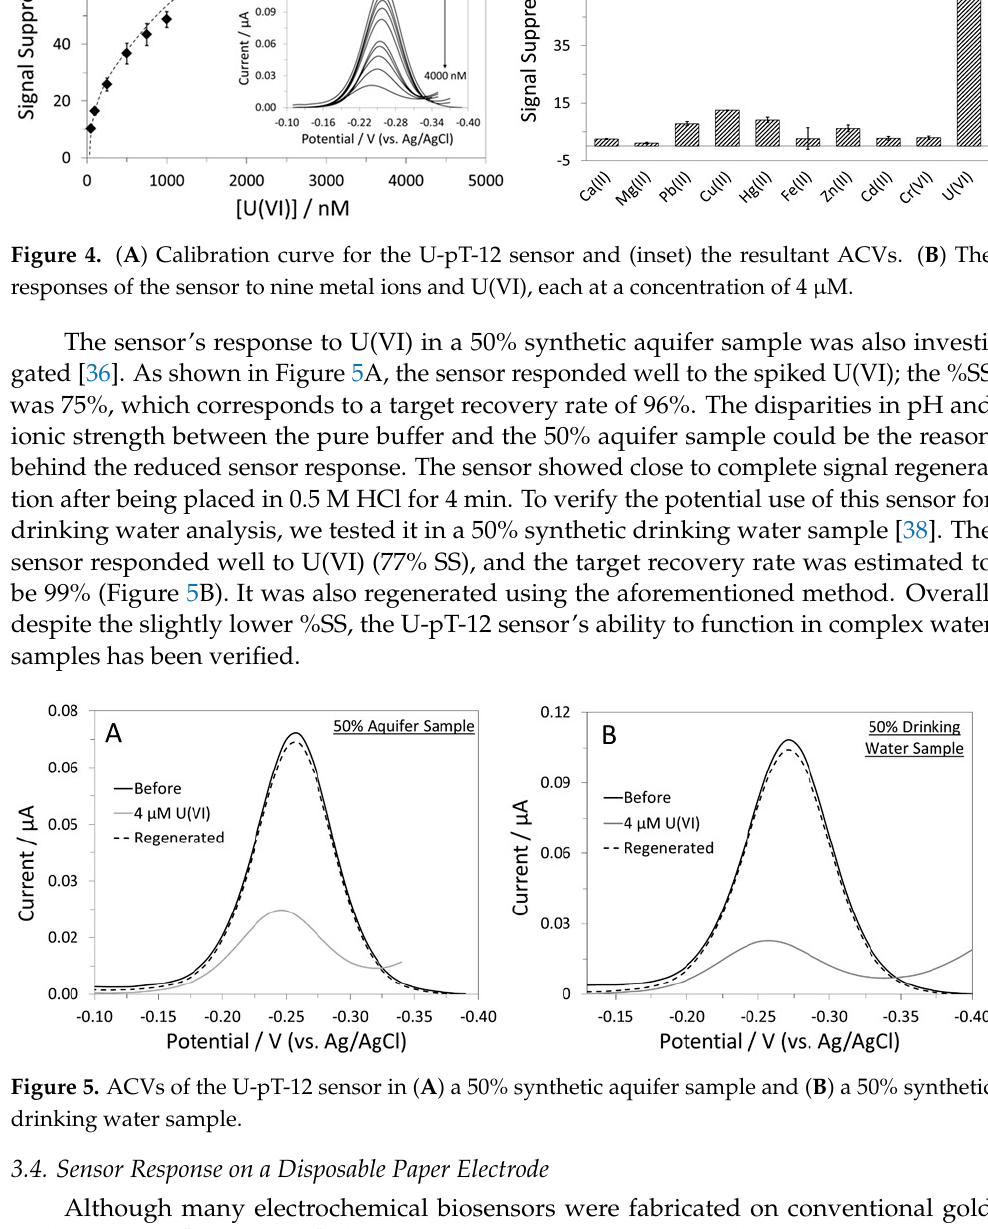
Figure 4. ( A ) Calibration curve for the U-pT-12 sensor and (inset) the resultant ACVs. ( B ) The re- sponses of the sensor to nine metal ions and U(VI), each at a concentration of 4 µM.